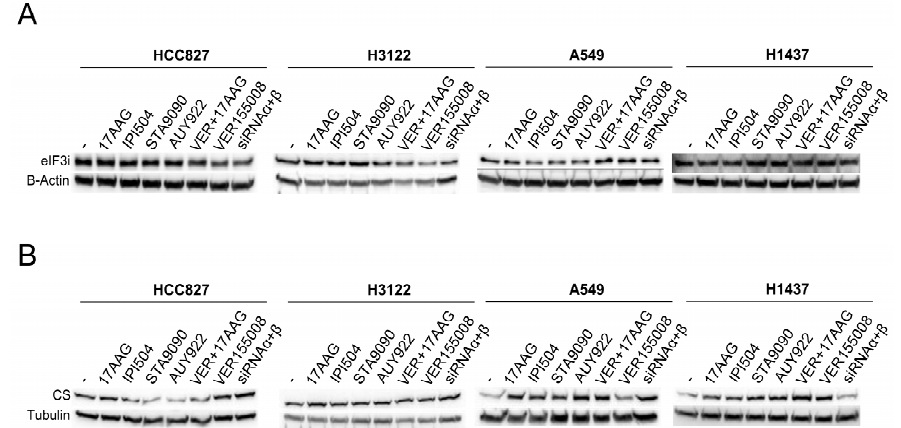
Figure 5. Western blotting validation of proteins identified as differentially expressed in the 2-DE/MS analysis. Protein lysates from HCC827, H3122, A549 and H1437 cells without treatment or inhibited with 17-AAG, IPI-504, STA-9090, AUY-922 VER-155008 + 17AAG and VER-155008 as well